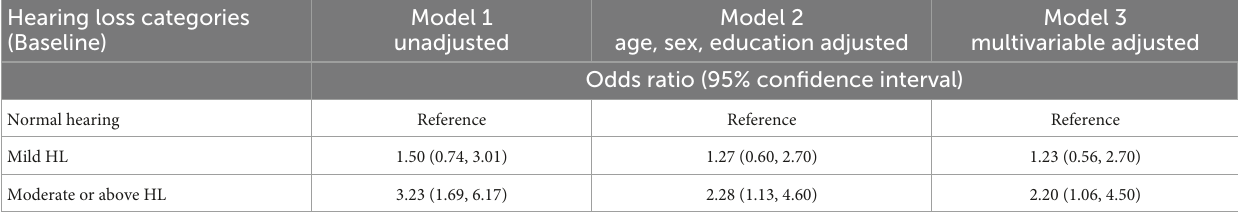
TABLE 2 Multivariable adjusted ORs and 95% CIs of the association between baseline hearing loss and 12 month cognitive